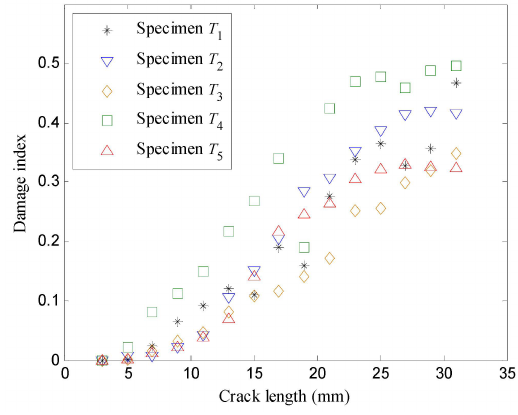
Figure 10. The damage indices versus the crack